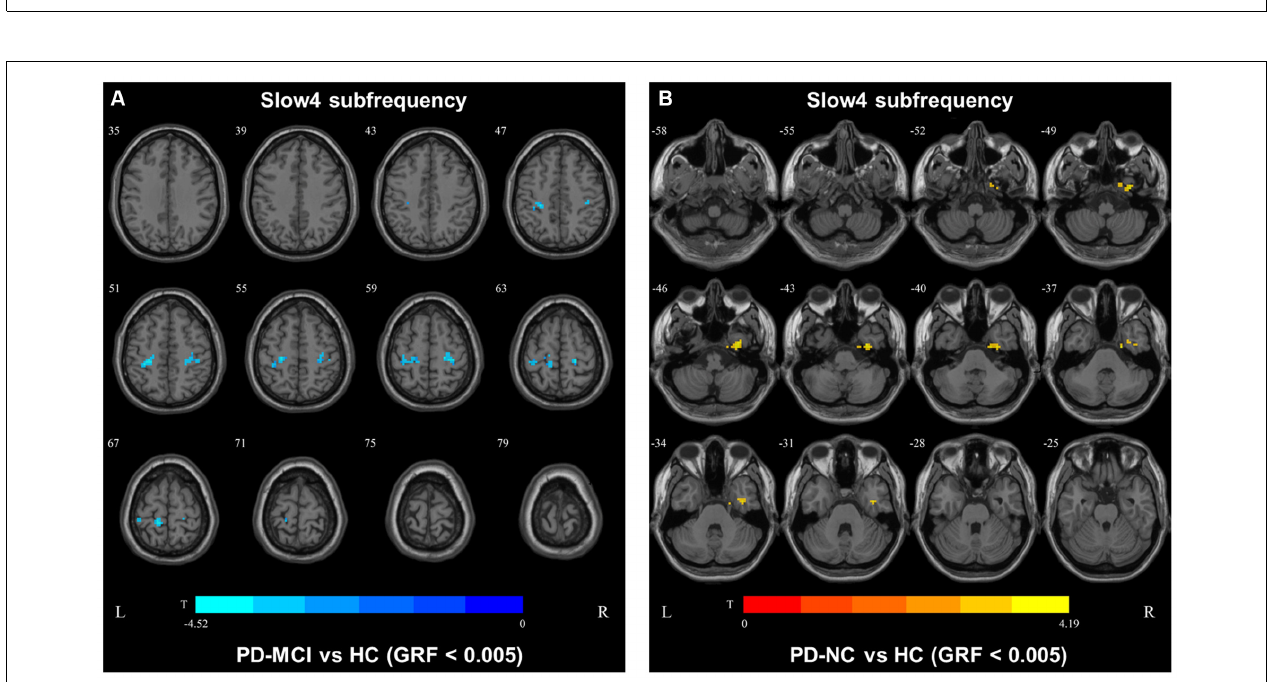
FIGURE 2 | DC map differences among the groups in slow4 subfrequency band. The DC results were compared by two sample t -tests (GRF corrected, voxel p < 0.005, cluster p < 0.05). The color bar on the bottom indicates the statistical t value. The warm (cold) color indicates a significantly increased (decreased) distant DC in the comparison. Additional details regarding these regions with difference are shown in Table 2 . (A) Decreased DC in PD-MCI patients between PD-MCI and HC. (B) Increased DC in PD-NC patients between PD-NC and HC.